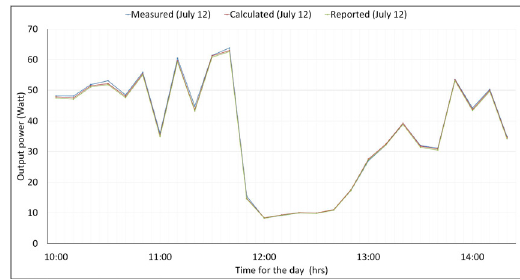
Figure 6. Output power for monsoon day, 12 th July of a-Si PV technology.